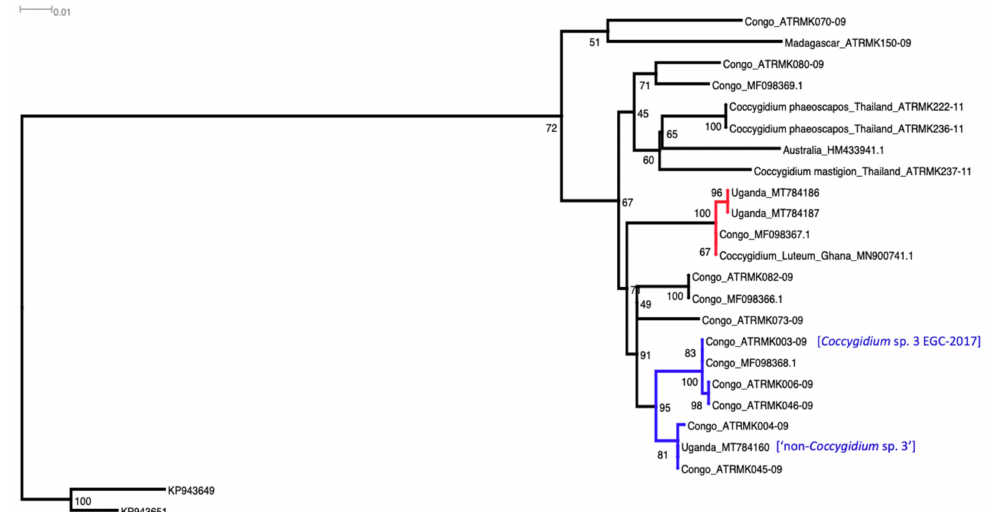
Figure 2. Phylogenetic placements of the Ugandan Coccygidium species, with two of the three sequences (GenBank MT784186, MT784187) being shown to cluster confidently with Coc. luteum from Ghana (MN900741) and Congo (MF098367), and the remaining one (GenBank MT784160) clustered with sequences as the sister clade to the “ Coccygidium . sp. 3 EGC-2017” individual (GenBank MF098368). The outgroup individuals were Agathis spp. from Mexico (KP943649) and the United States of America (KP943651)